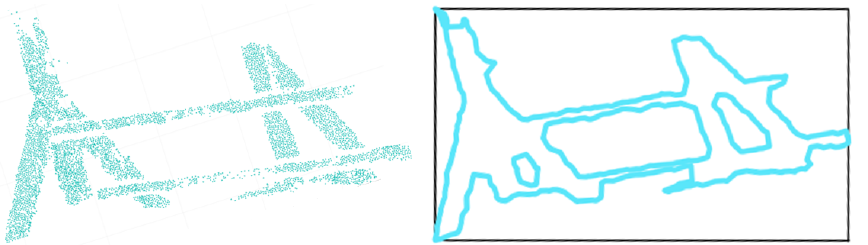
Figure 12. An example of type-2 segment points that cannot be split automatically ( left ), the alpha- shape (turquoise) and minimum bounding box (black) of the segment ( right